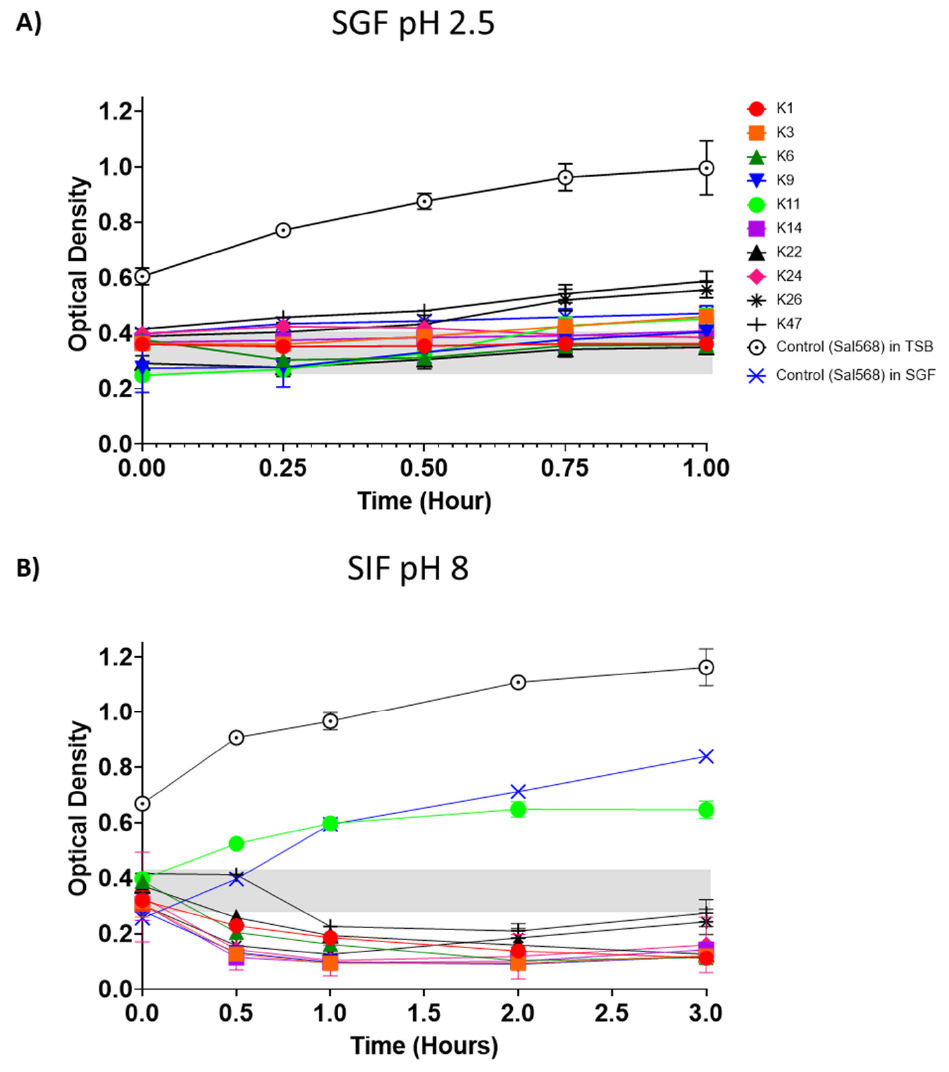
Figure 6. Control of S . Enteritidis growth by phages in SGF and SIF. ( A ) Effect of SGF on phage efficiency to control the growth of S . Enteritidis Sal568. ( B ) Effect of SIF on phage efficiency to control the growth of S . Enteritidis Sal568. The optical density (OD 600 nm ) of the mixture of S . Enteritidis Sal568 (10 6 CFU/mL) and the 10 phages (4.5 × 10 7 PFU/mL) were measured at 0, 0.5, 1, 1.5, 2, 2.5, 3, 3.5, and 4 h. The grey shading indicates initial OD values at the start of the experiment. All experiments were repeated twice and measured in triplicate. Error bars represent the standard error of the mean (±SE).